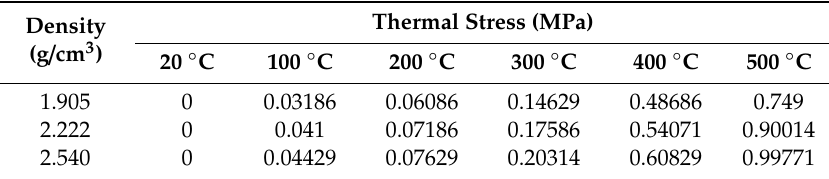
Table 3. The thermal stress values of the EMWM under di ff erent ambient temperature. Density